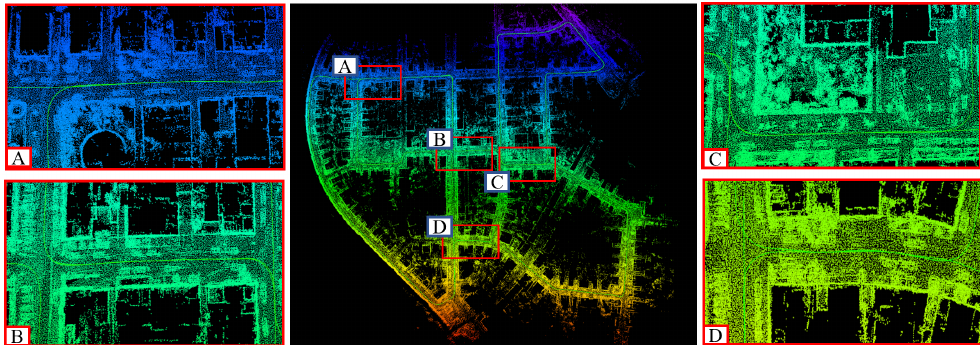
Figure 10. Our mapping result on KITTI dataset sequence 00. ( A – D ) are some of the loop closures found in our